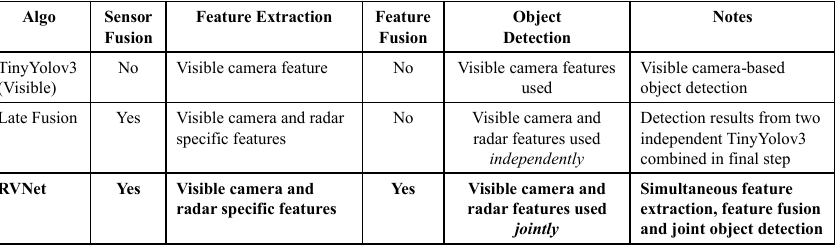
Figure 6. RVNet compared with the baseline algorithms. Contributions to literature highlighted. TVNet Baseline Algorithms: Multiple algorithms based on the tiny YOLOv3 net- work [27] are used as the baseline